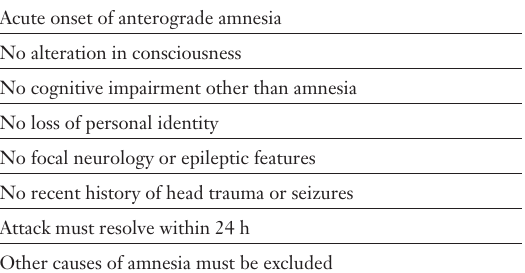
Diagnostic criteria according to Caplan and Hodges.